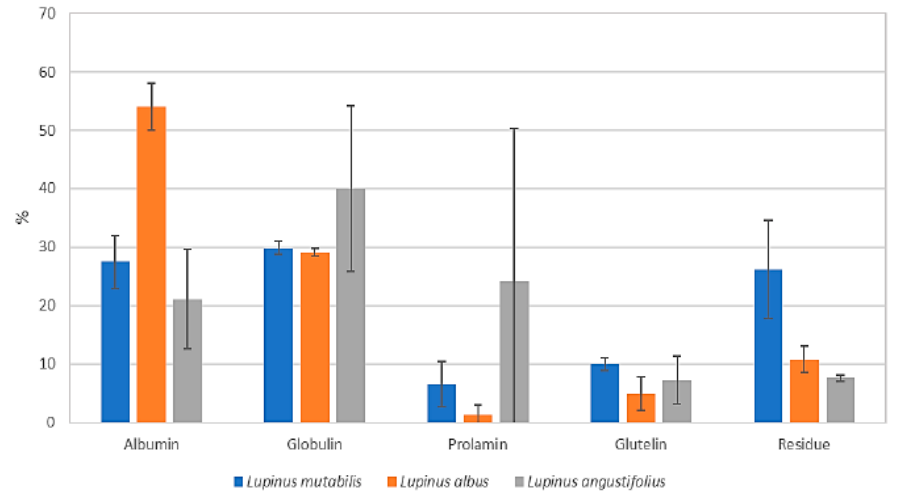
Figure 5. Osborne’s protein solubility profile (percentage, %) of lupin flour of different varieties.